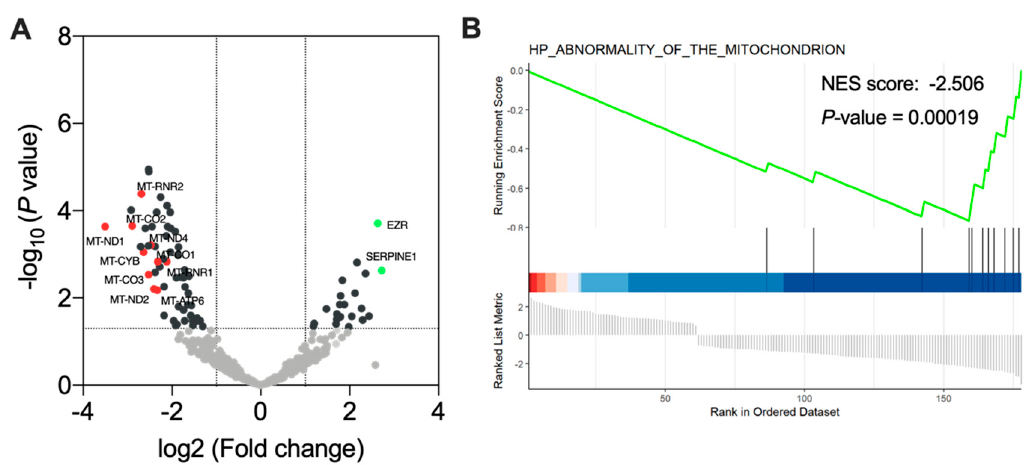
Figure 5. Ponatinib induced mitochondrial dysfunction: ( A ) Volcano plot of differentially expressed genes between ponatinib-treated and untreated meningiomas. Red dots: downregulated mitochondrial-related genes (log2 fold change ≤ − 1; FDR < 0.05). Green dots: upregulated genes (log2 fold change ≥ 1; FDR < 0.05). ( B ) The results of gene set enrichment analysis (GESA) for GO gene sets.